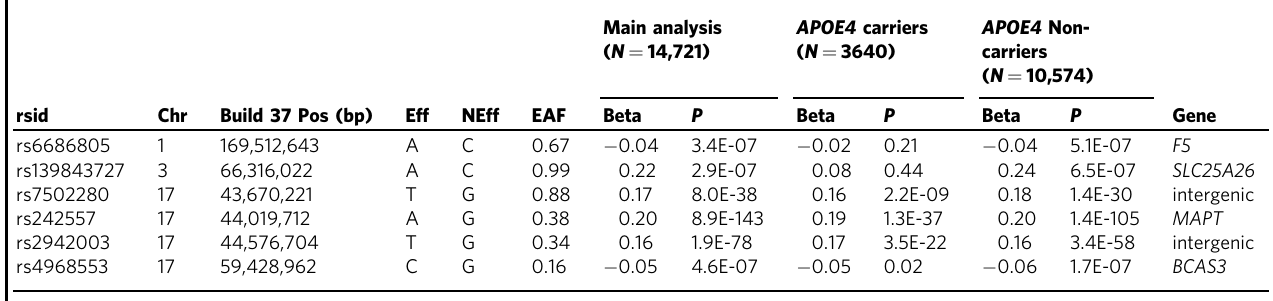
Table 4 Results of the APOE4 -strati fi ed analyses for the lead genetic variants in each locus passing the threshold of P < 5 × 10 − 7 in the European meta-analysis of GWAS of circulating total-tau